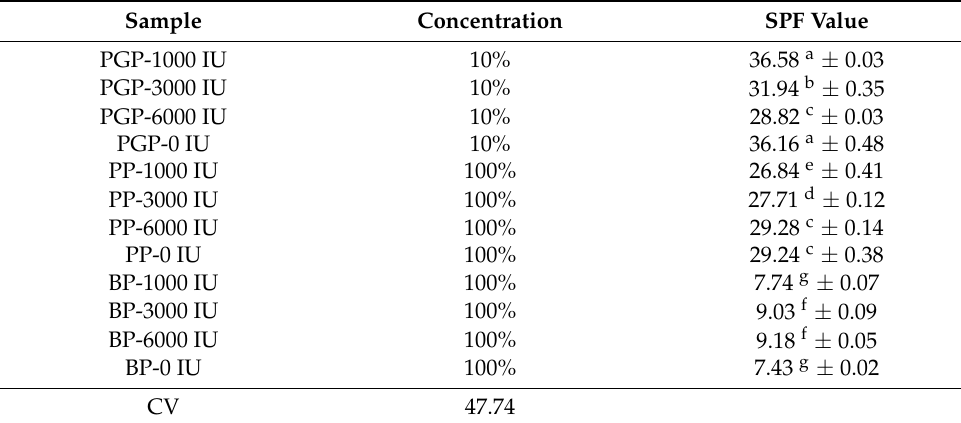
Table 10. SPF values of three fermented fruit peel